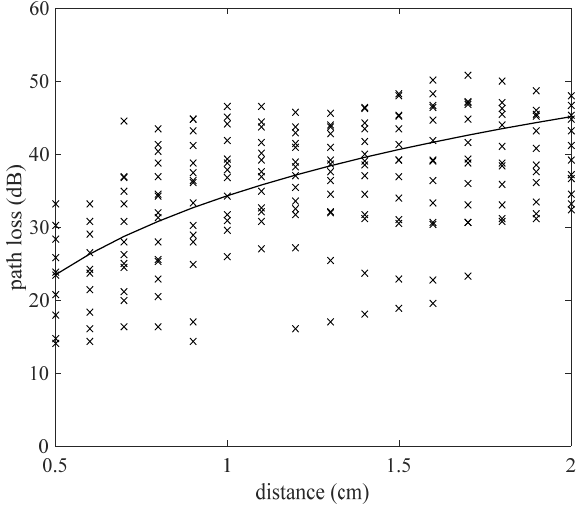
Figure 4. Path loss model versus distance between Tx and Rx antennas. Table 3. Simulation Results of the Path Loss Model.